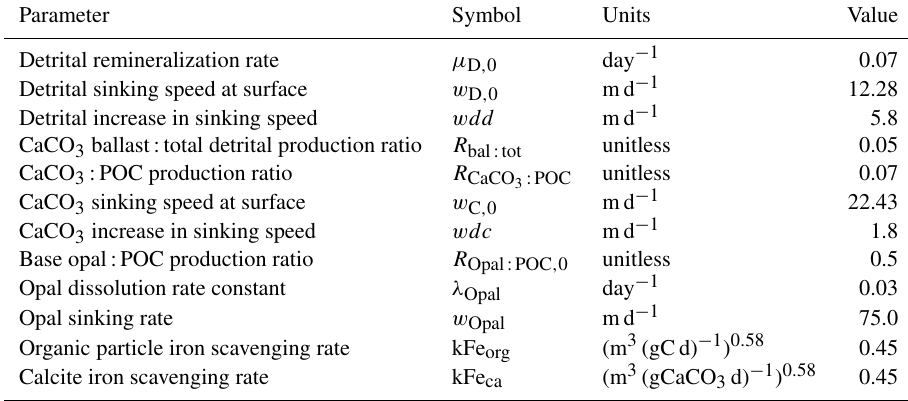
Table 5. KMBM3 particle export–production parameters.